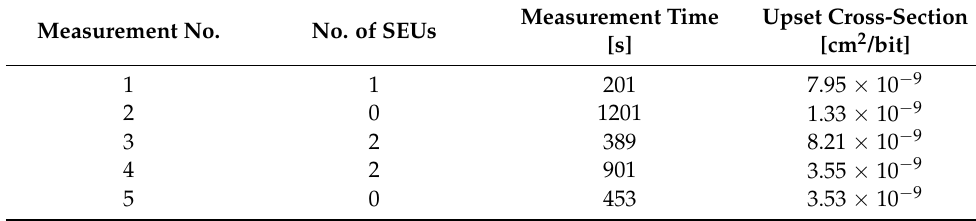
Table 4. SEU results under Ar irradiation. Measurement No.